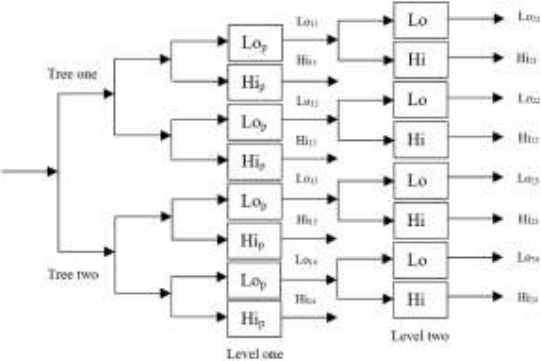
Figure 5. Two levels of 2D DD-DT CWT